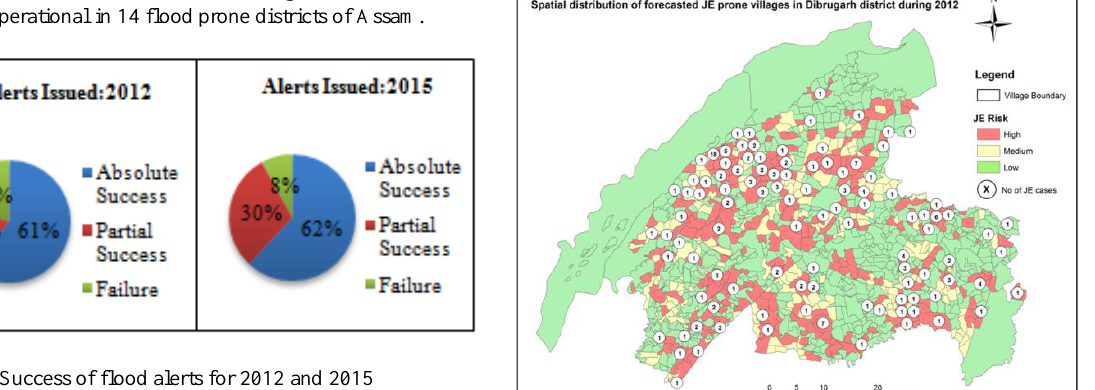
Figure 5. Success of flood alerts for 2012 and 2015